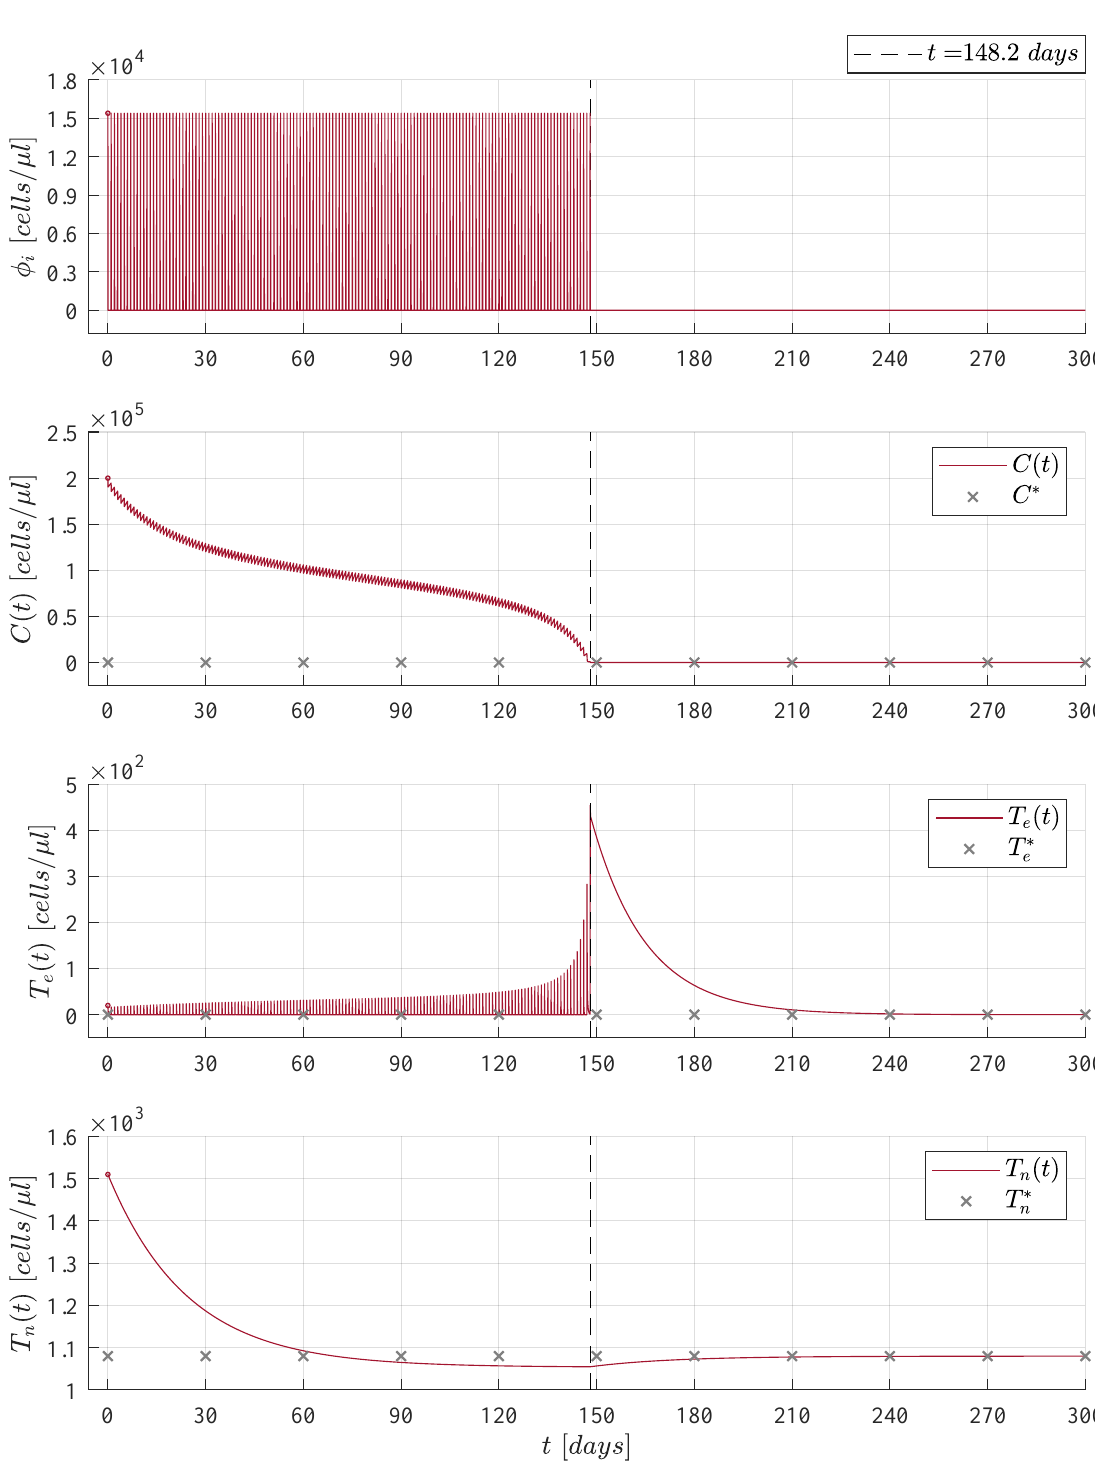
Figure 4. Case 2: The initial tumour size for the CML cancer cells is set as C ( 0 ) = 2 immunotherapy φ i had to be applied 148.2 days to achieve complete leukemia cancer cells